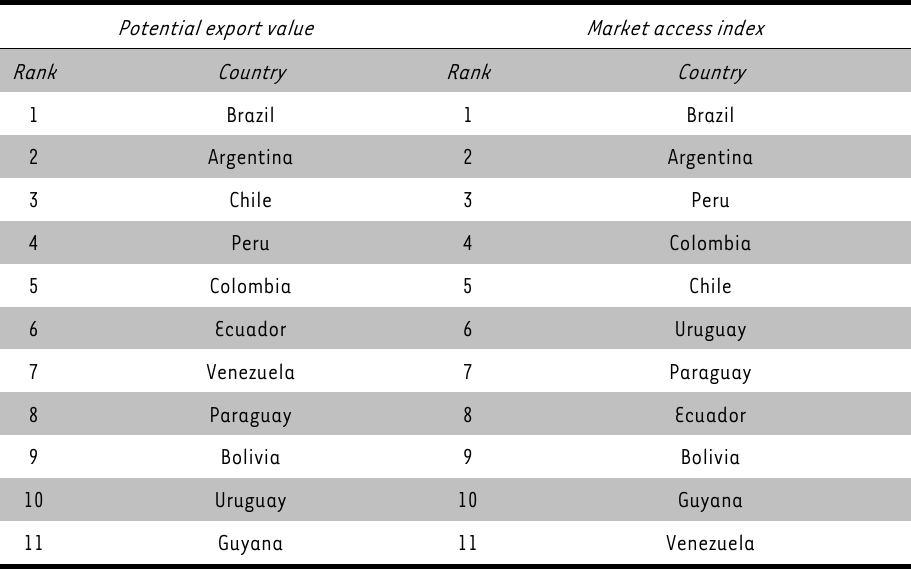
TABLE 12: South American countries’ ranking in terms of potential export value and